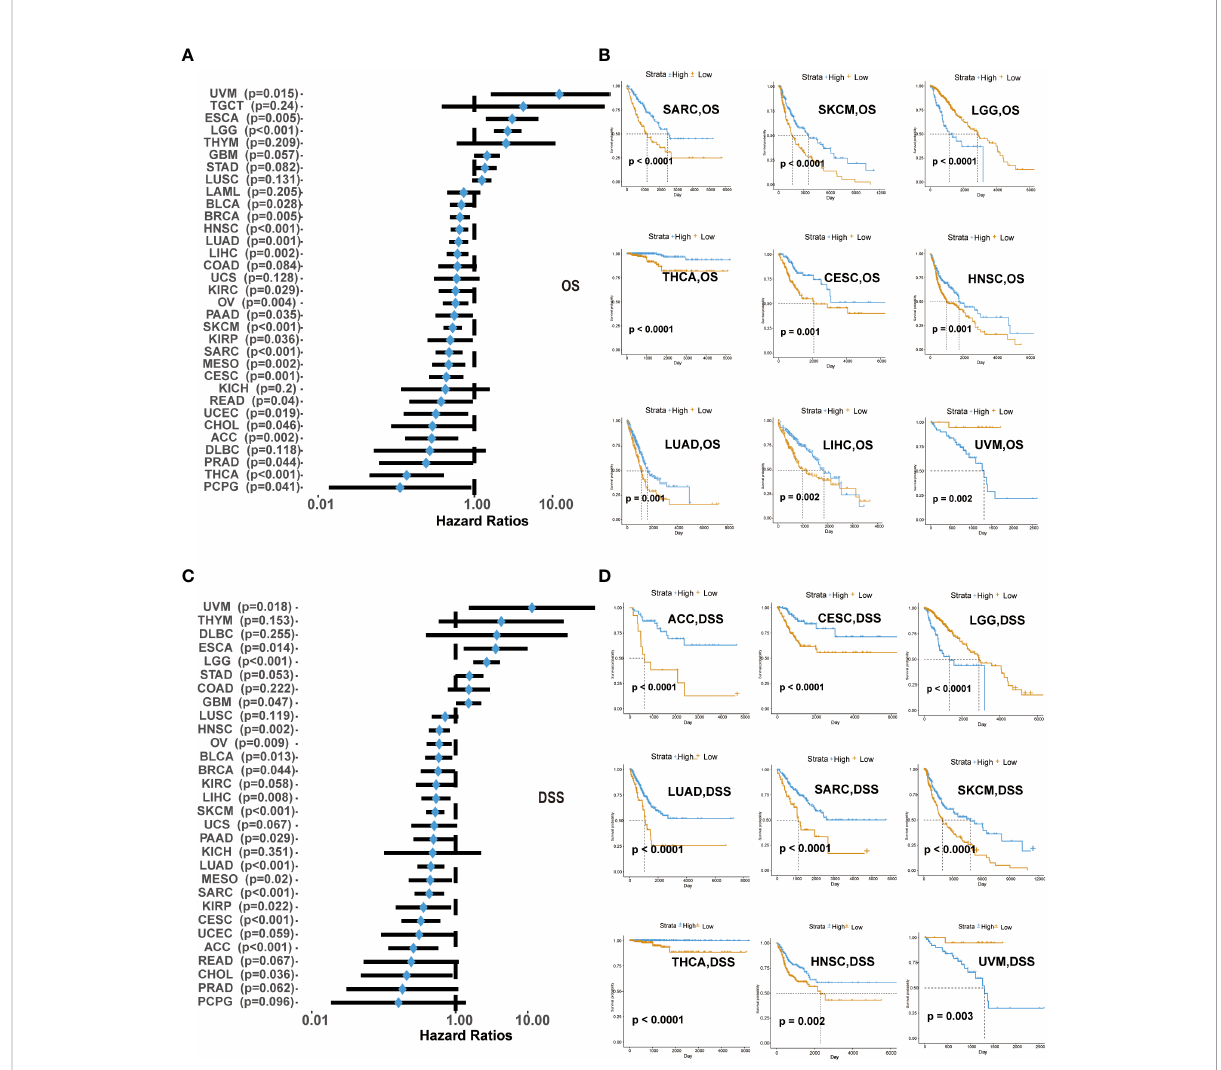
FIGURE 2 Correlation of CD161 expression with OS in 33 types of cancer (A) . Kaplan-Meier analysis of OS in patients with high and low expression of CD161 in SARC, SKCM, LGG, THCA, CESC, HNSC, LUAD, LIHC, and UVM (B) . CD161 expression with DSS in TCGA cancers (C) . Kaplan-Meier analysis of DSS in patients with high and low expression of CD161 in ACC, CESC, LGG, LUAD, SARC, SKCM, THCA, HNSC, and UVM (D)